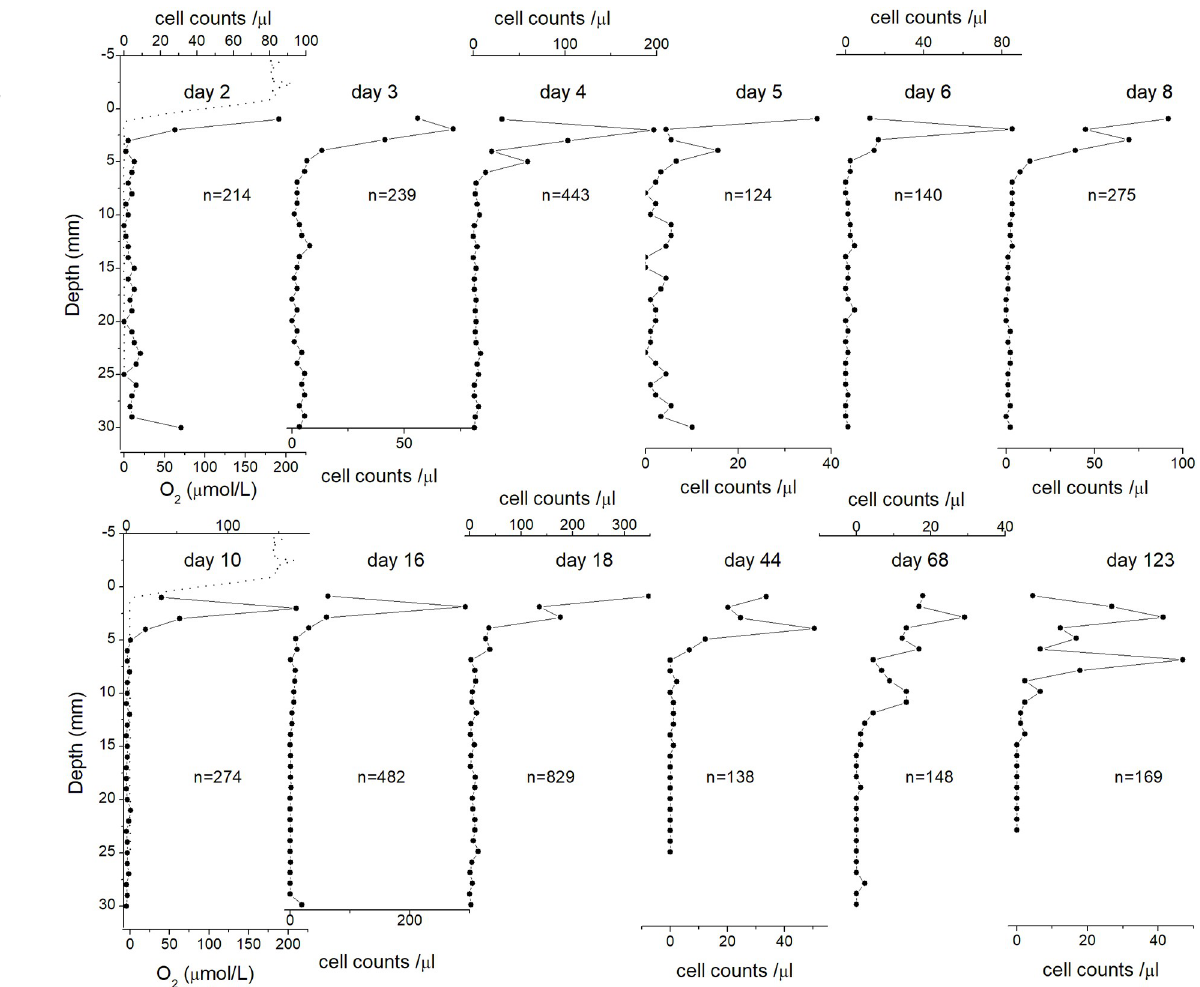
Fig 5. Vertical distribution changes with time. Development of cocci vertical distribution (square) and oxygen gradient (dotted line).